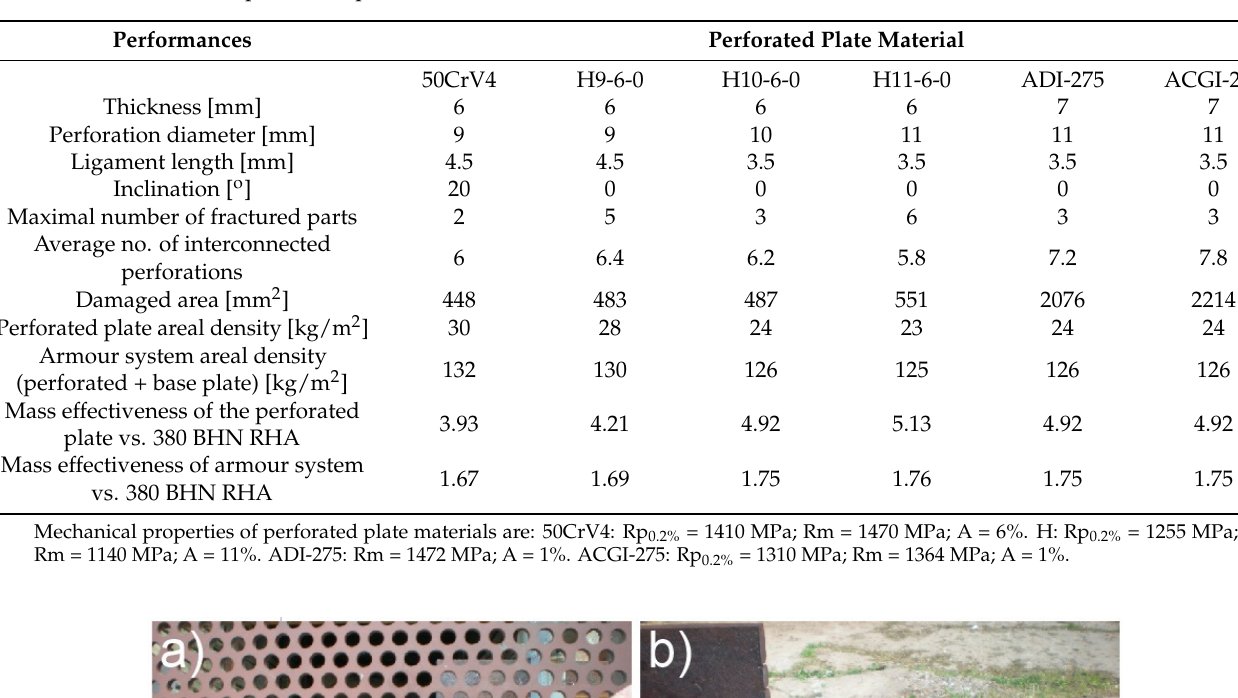
Table 2. Geometry, the average number of interconnected perforations, damaged area, areal density and mass effectiveness of various successful perforated plates [10,35,37,38].